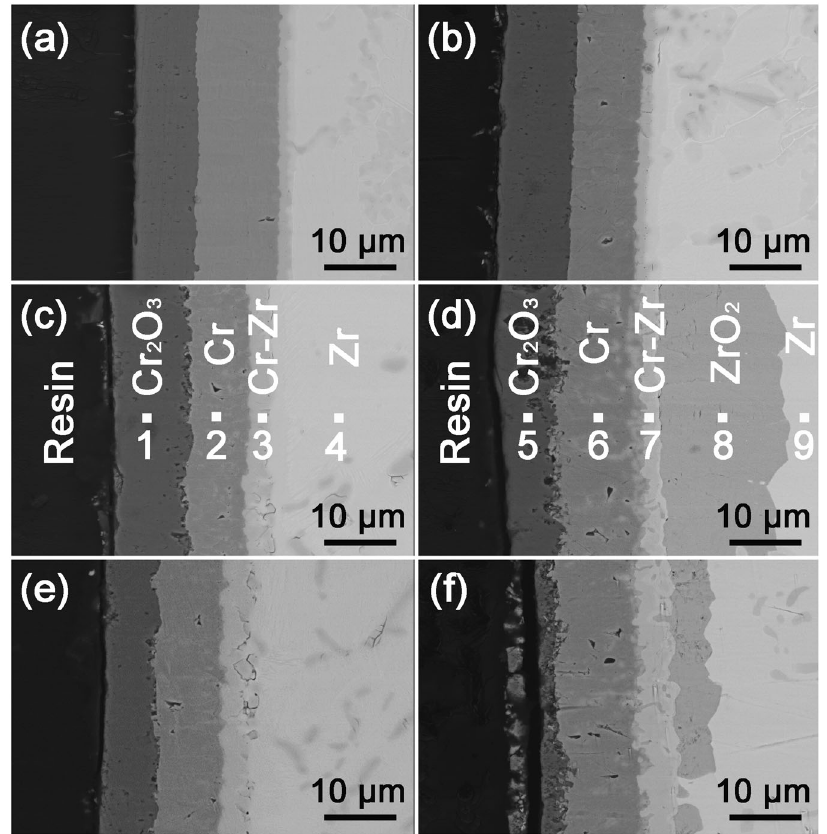
Fig. 4 Cross-sectional SEM images of the outer surface of Cr-coated Zr tube oxidized at different conditions. a , b 1200 o C/0.5 h, c , d 1200 o C/1 h, e , f 1200 o C/2 h, g , h 1200 o C/4 h, i , j 1300 o C/0.5 h, k , l 1300 o C/1